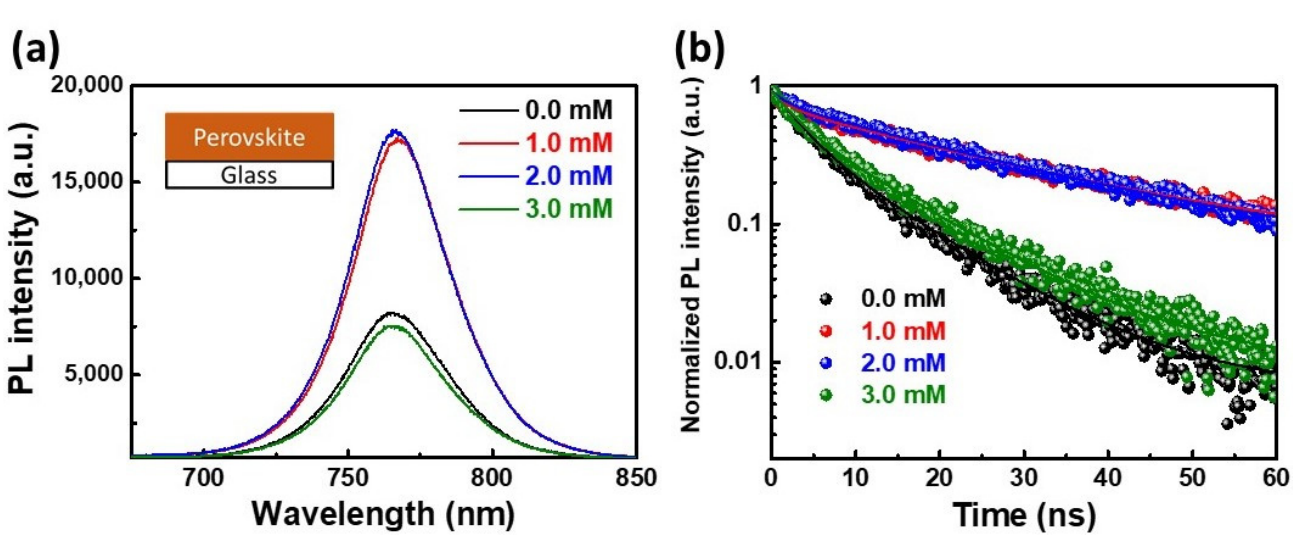
Figure 3. ( a ) PL and ( b ) TRPL spectra of pristine, 1.0, 2.0, and 3.0 mM Tween 20 perovskite films. Table 1. Summary of the fast decay lifetime ( τ 1 ), the slow decay lifetime ( τ 2 ), and the average decay lifetime ( τ avg ) for MAPbI 3 perovskite